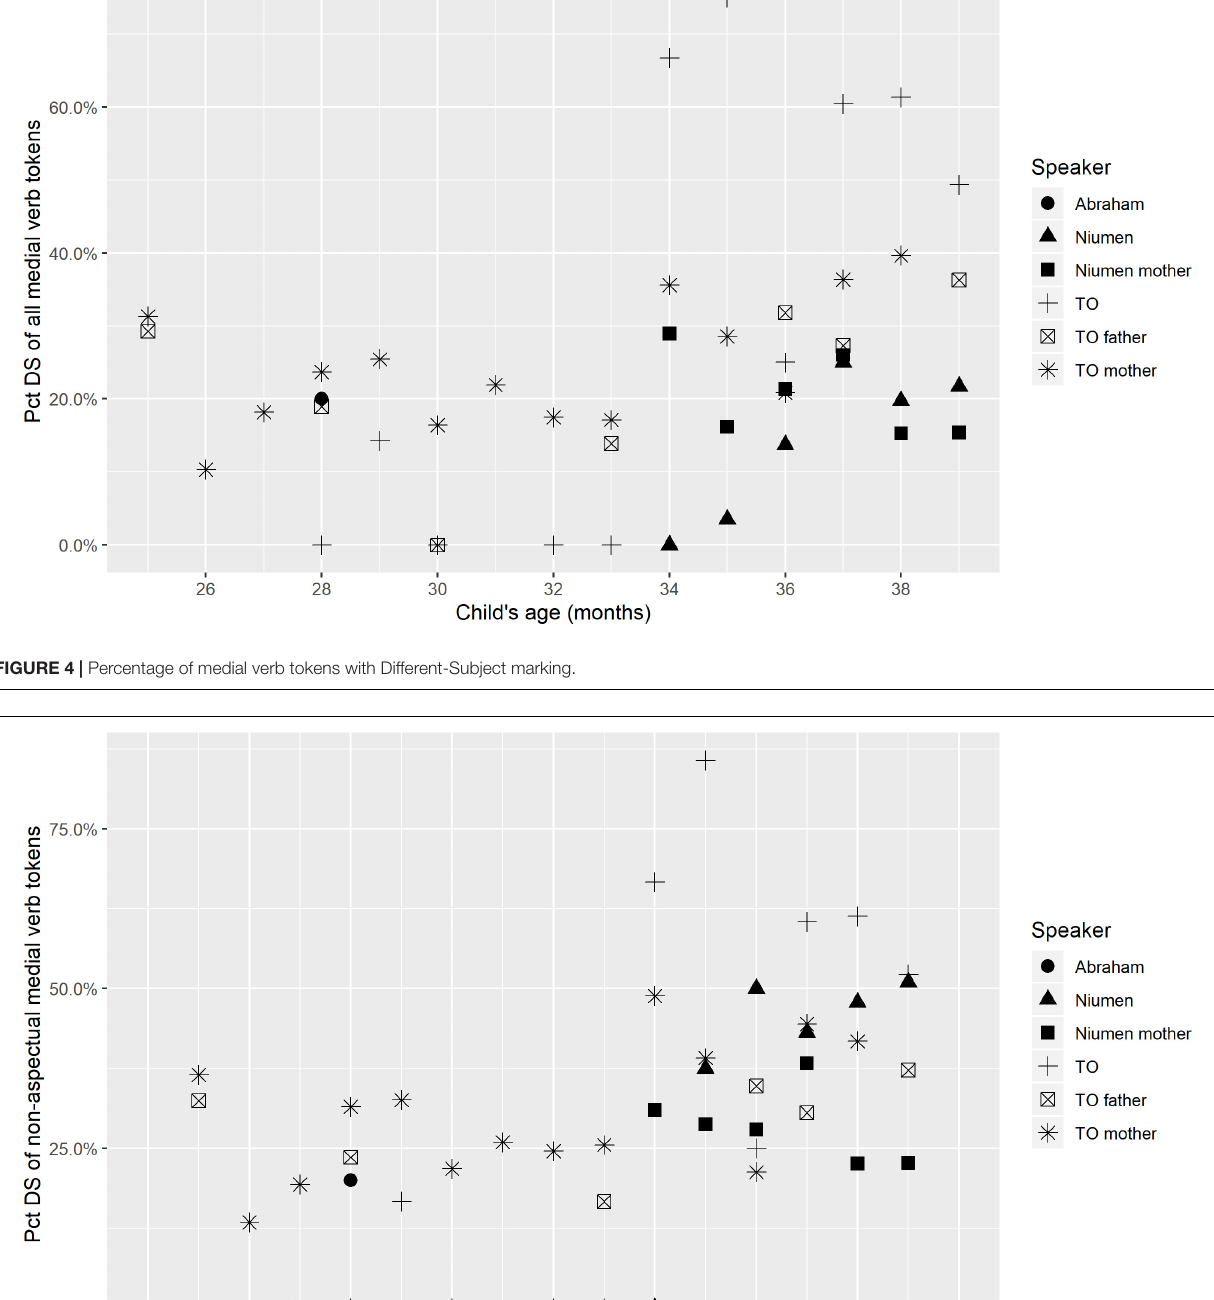
to be SS, but these transcripts stem from recording sessions at very different ages: 2;4 for TO and 2;10 for Niumen. Both children then produce a mix of SS and DS forms in the very next recording